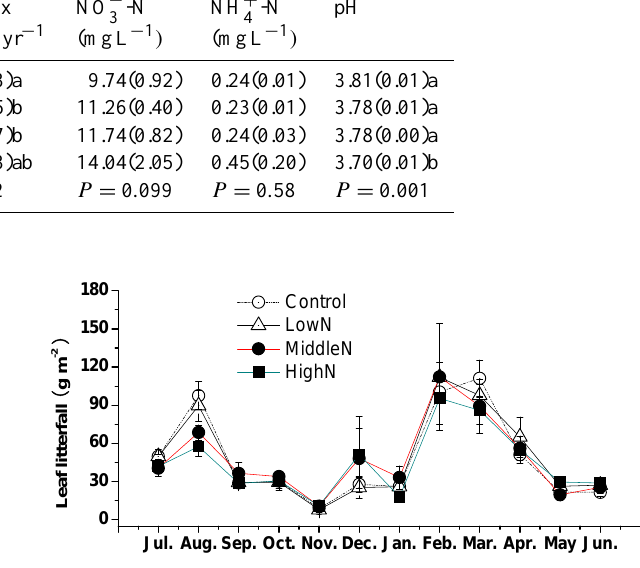
Fig. 3. Monthly dynamics of litterfall with elevated N addition in the lowland tropical forests of Southern China during the study